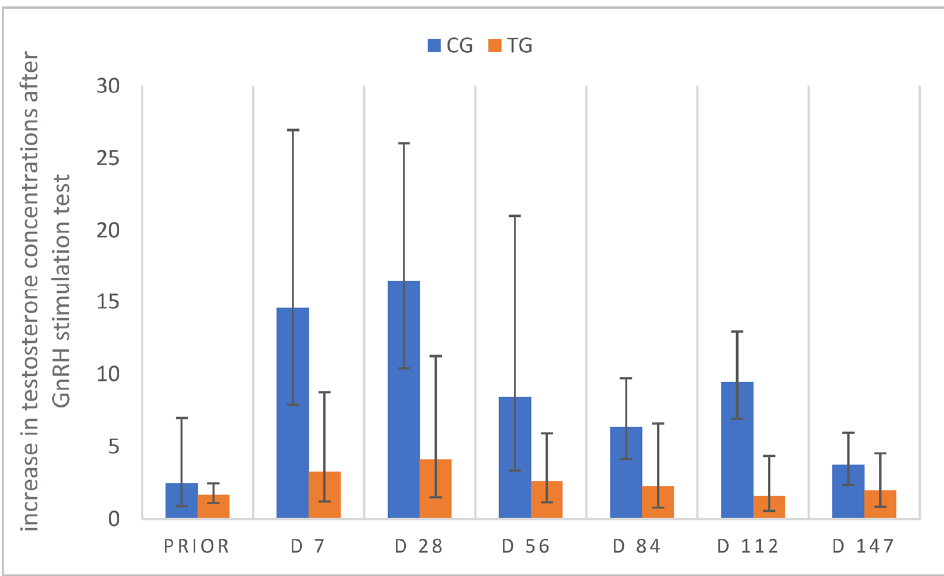
Figure 10. Relative increase in plasma testosterone concentrations 60 min after GnRH stimulation; testosterone values before stimulation are considered as 1, relative increase from pre- to post- stimula- tion is presented for study day PRIOR (day 14 prior to treatment), D7, D28, D56, D84, D112, D147; animals treated with 4.7 mg deslorelin implant (TG, n = 7); saline-treated control animals (CG, n = 3). Results are given as geometric mean x g (DF). “Prior” indicates “prior to